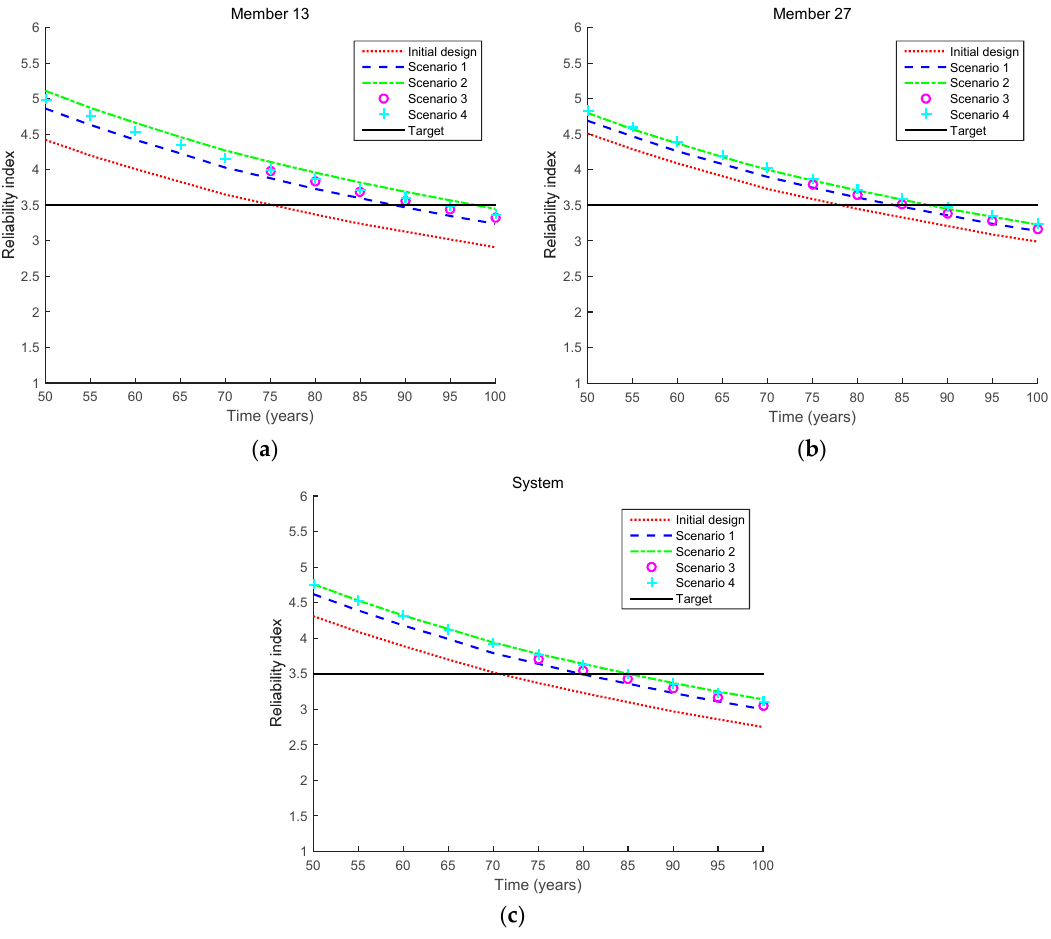
Figure 8. Comparison of updated reliability indices for inequality cases (Scenarios 1–4 in Table 3). ( a ) Member 13; ( b ) Member 27; ( c ) System. Table 4. Fatigue lives for inequality cases (Scenarios 1–4 in Table 3).